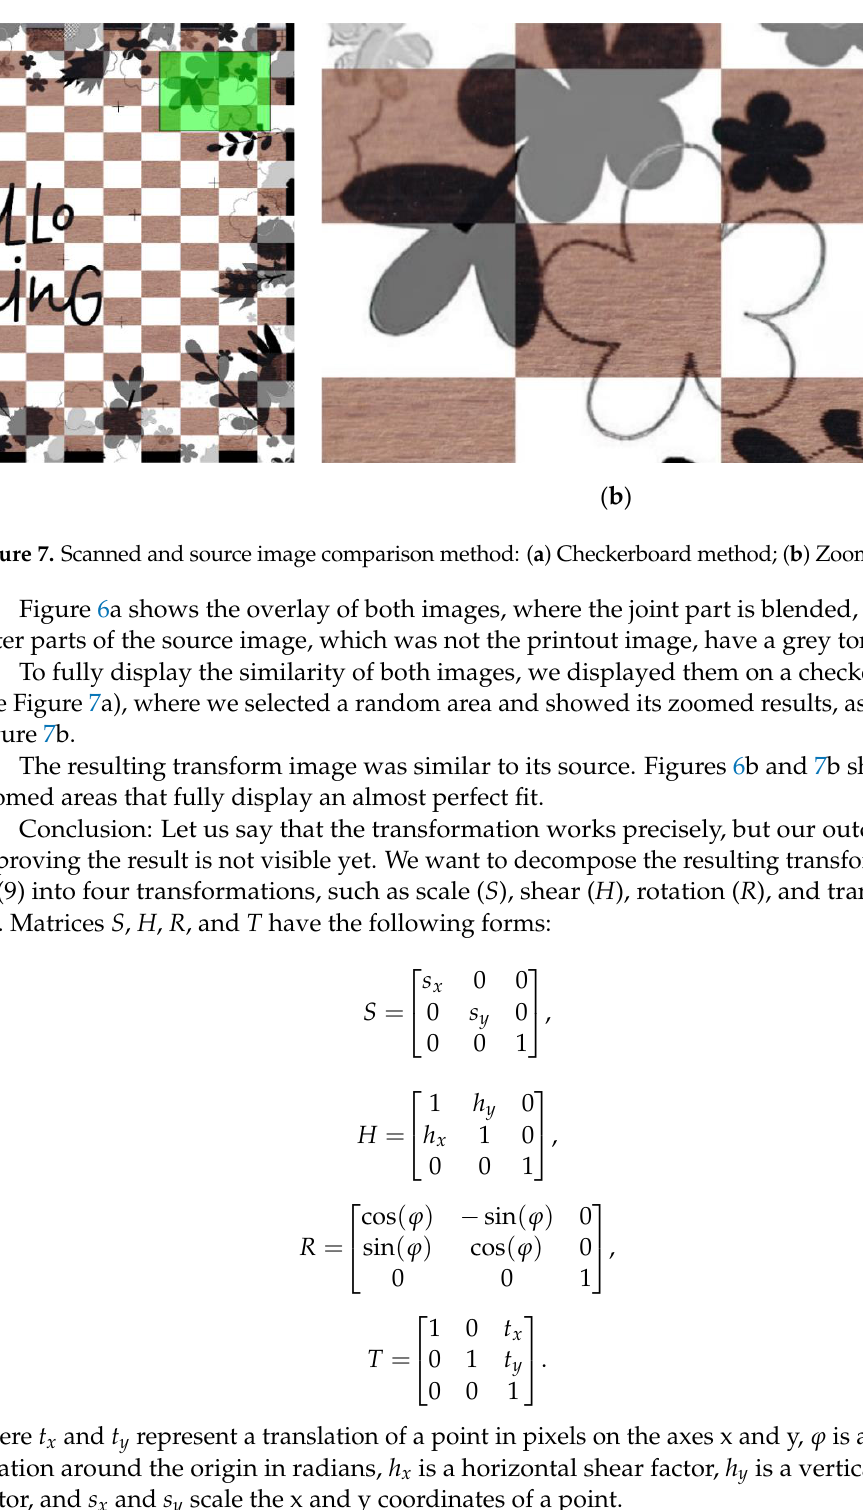
7 of 18 Figure 6. Scanned and source image comparison method: ( a ) Blend method; ( b ) Diff method, zoomed selected landmarks (position of landmarks see Figure 3b).